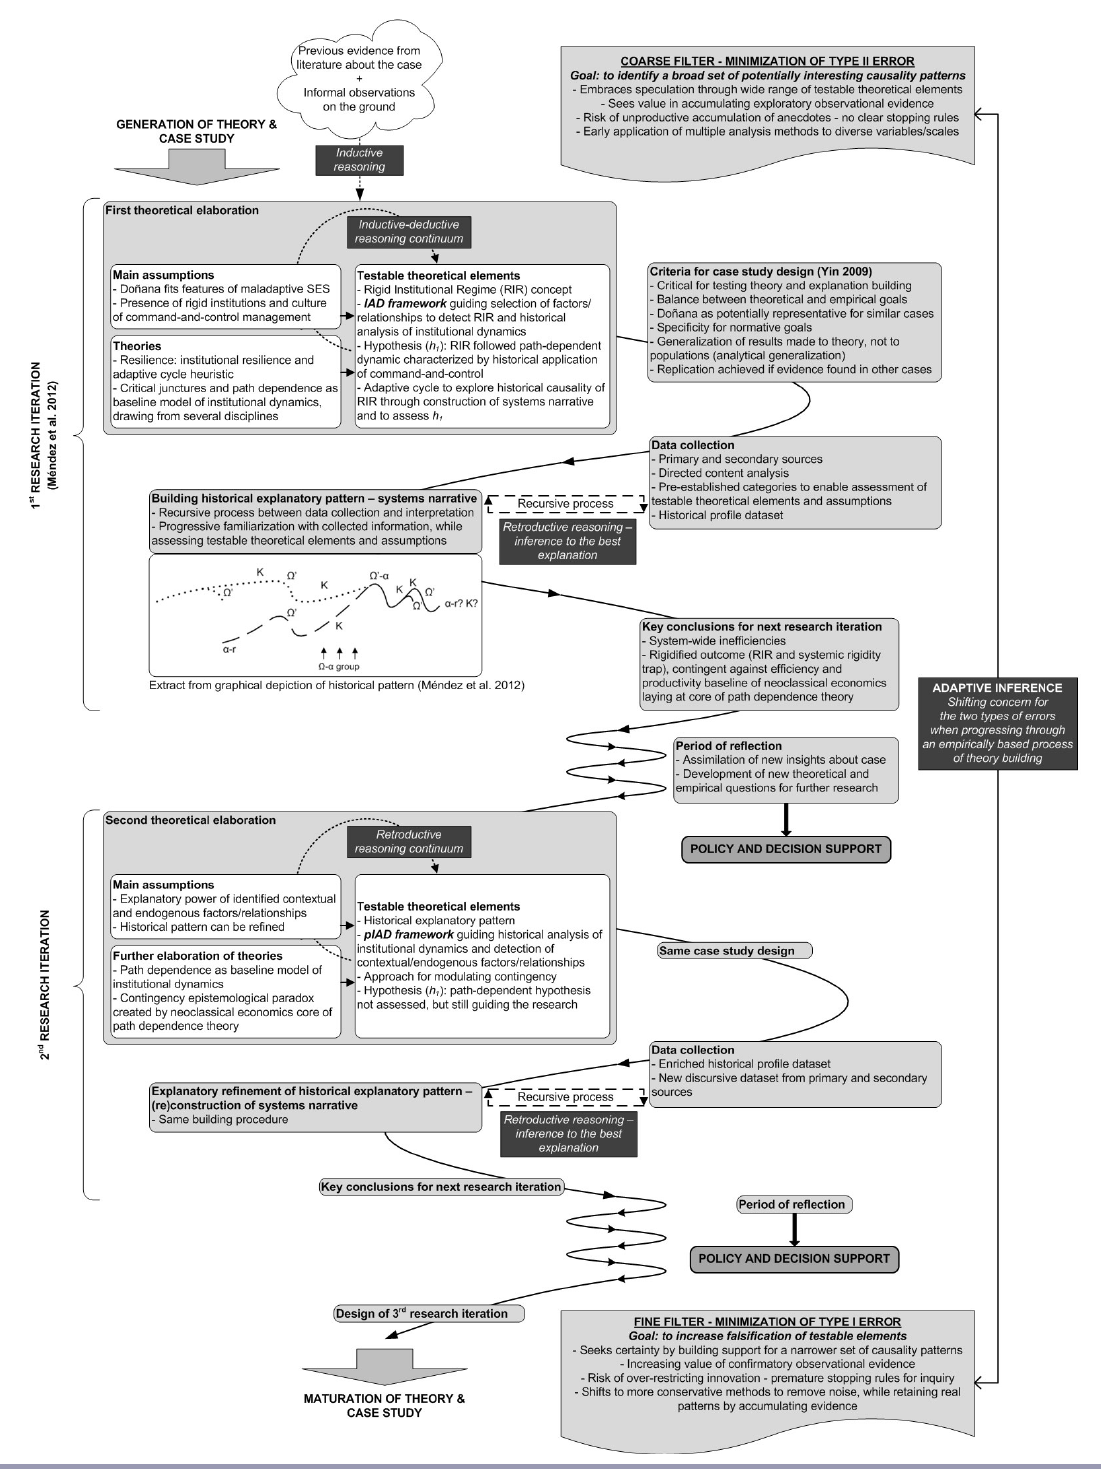
Fig. 2 . Iterative process, methodological approach, and adaptive inference procedure of our social-ecological research program in Doñana, Spain. IAD framework = Institutional Analysis and Development framework; pIAD = politicized version of the IAD. Source: modified from Holling and Allen